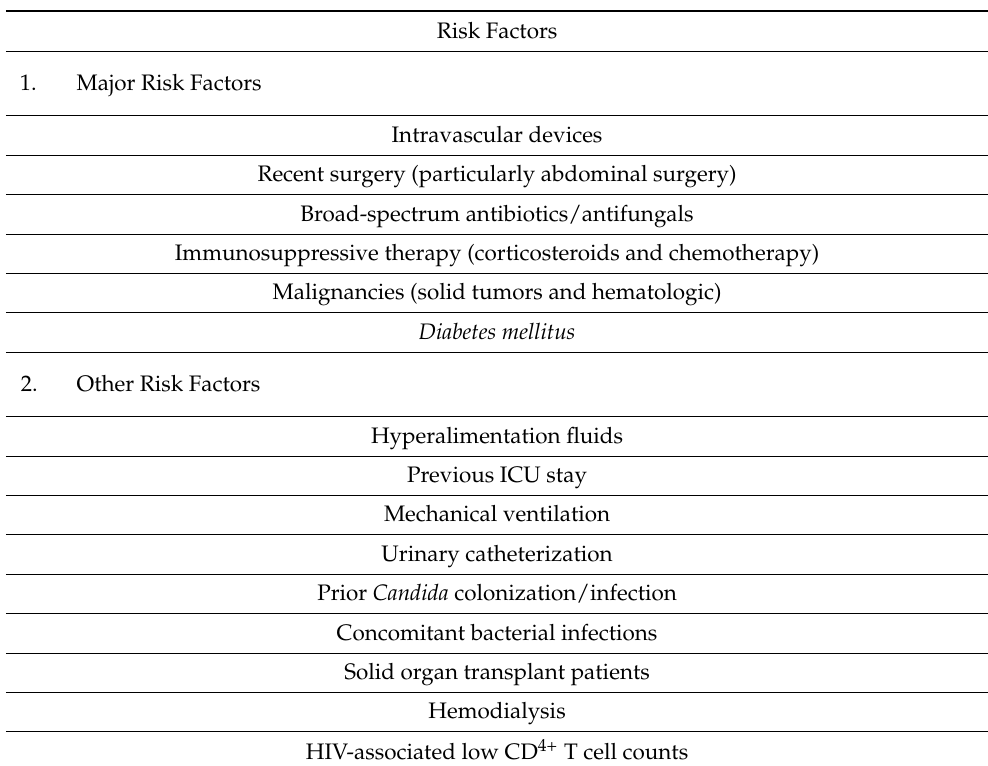
Table 1. Risk Factors for Invasive